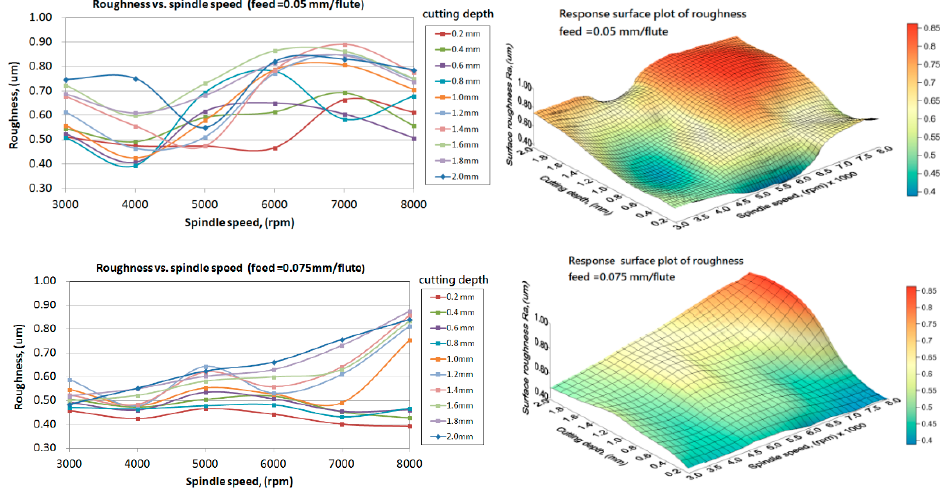
Figure 7. Variation of surface roughness with varying spindle speed and cutting depth at lower and higher feed rate, respectively.